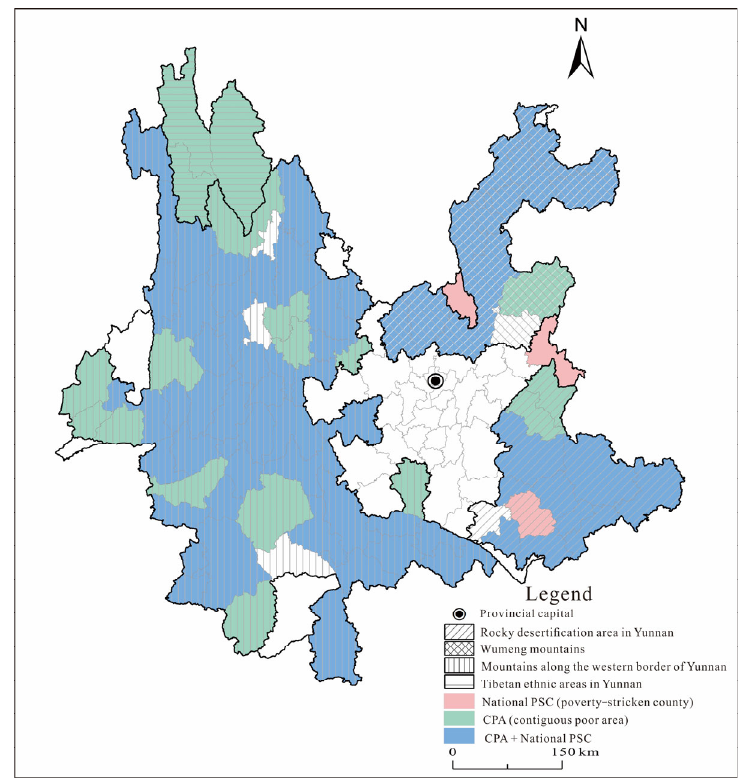
Figure 1. Distribution of CDAs and poor counties in Yunnan in 2020.